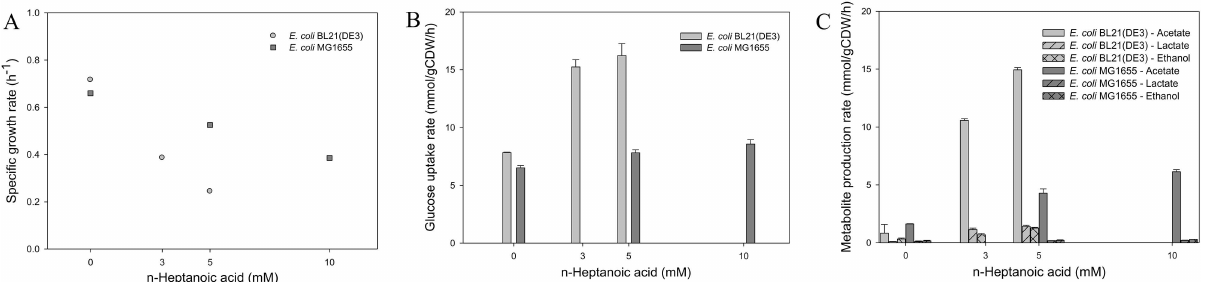
Fig 1. The specific growth rates (A), specific glucose uptake rates (B), and specific metabolite production rates (C) of the E . coli strains. E . coli BL21(DE3) ( grey ) and K-12 MG1655 ( dark grey ) were cultivated with different concentrations of n-heptanoicacid at 37˚C in a shaking incubator (200 rpm). Values are the mean of more than three independent samples. Bars represent standard error of the mean.